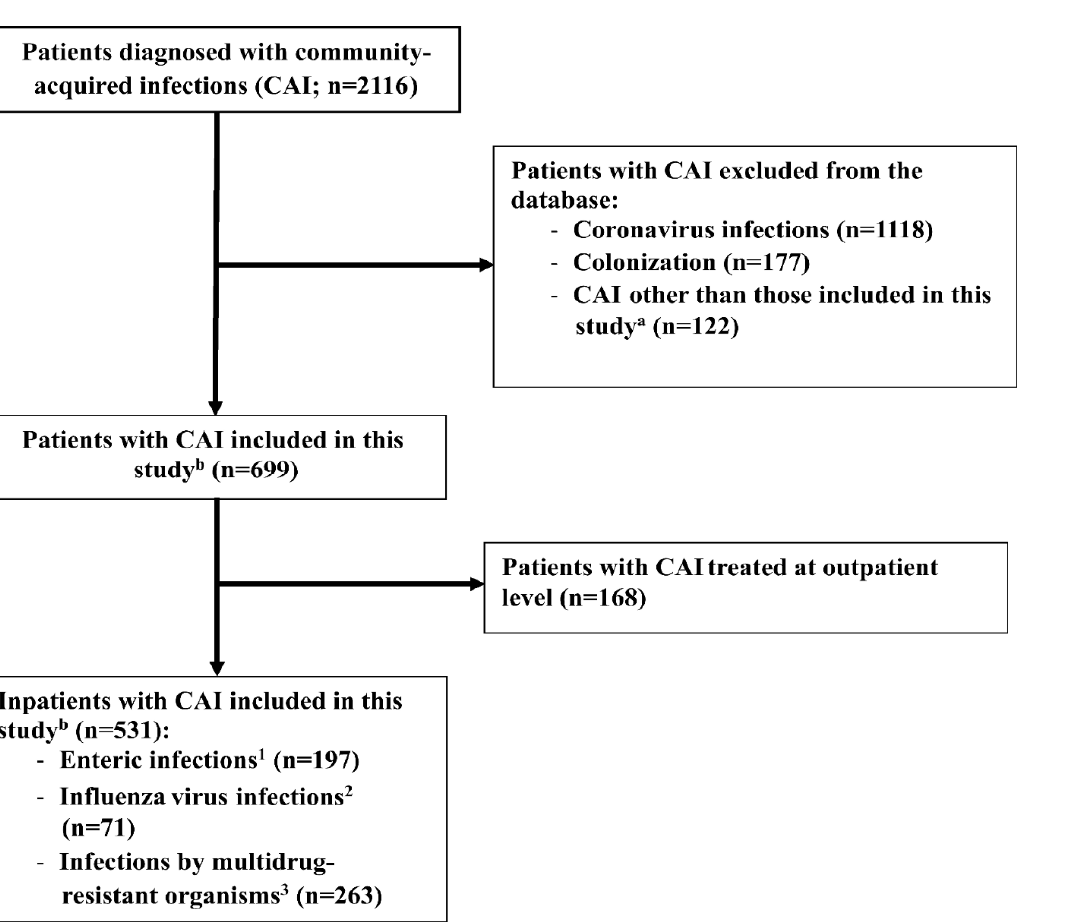
Figure 1. Flowchart of database development. a Patients with CAI caused by Adenovirus, Hepatitis viruses, Herpes viruses, Respiratory syncitial virus, Legionella pneumophila, Neisseria meningitidis, Streptococcus pneumoniae, Haemophilus influenzae, Mycobacterium tuberculosis, Yersinia enterocolitica, Shigella sonnei, Enteropathogen Escherichia coli , Clostridium perfringens, Entamoeba hystolitica, Giardia lamblia and HIV virus. b Patients with CAI caused by Campylobacter jejuni 1 , Campylobacter coli 1 , Rotavirus 1 , Salmonella sp. 1 , Clostridioides difficile 1 , Influenza A and B viruses 2 , Methicillin-resistant Staphylococcus aureus 3 , Vancomycin-resistant Enterococcus spp. 3 , Multidrug-resistant (MDR) Acinetobacter baumannii 3 , MDR Escherichia coli 3 , MDR Enterobacter spp. 3 , MDR Klebsiella spp. 3 , MDR Pseudomonas aeruginosa 3 , MDR Proteus mirabilis 3 , MDR Citrobacter freundii 3 , MDR Morganella morganii 3 and MDR Stenotrophomonas maltophilia 3